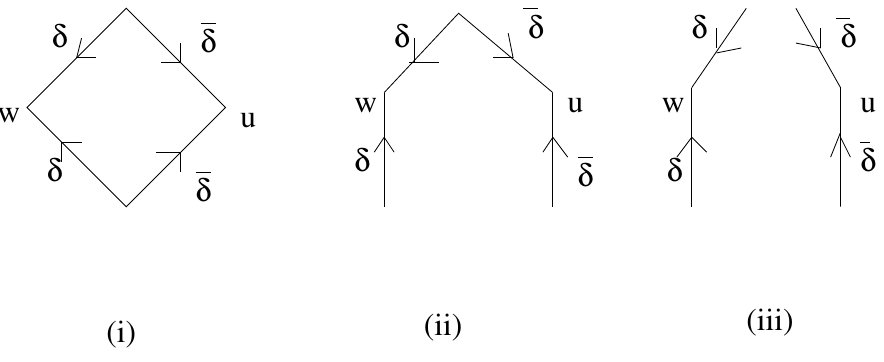
Figure 3 . Skeleton graphs for (i) (cid:8) 1 ;A , (ii) (cid:8) 2 ;A and (iii) (cid:8) 3 ;A .